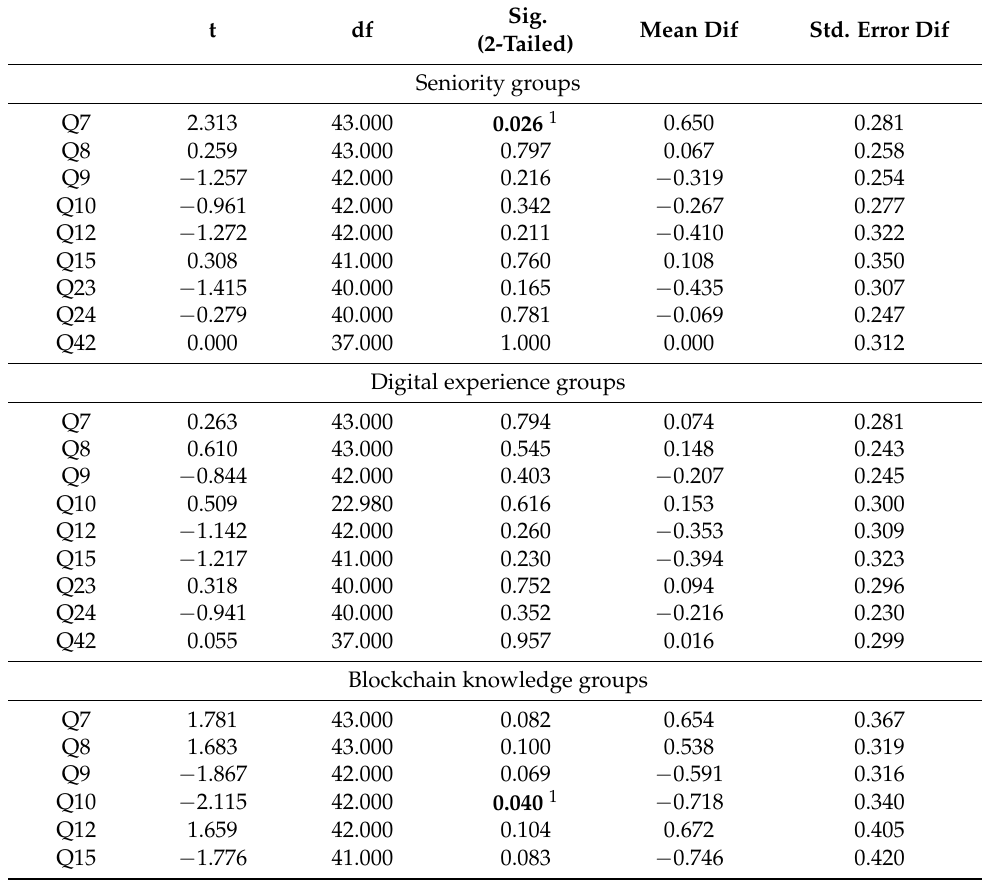
Table 13. Independent samples test—Levene’s test for equality of